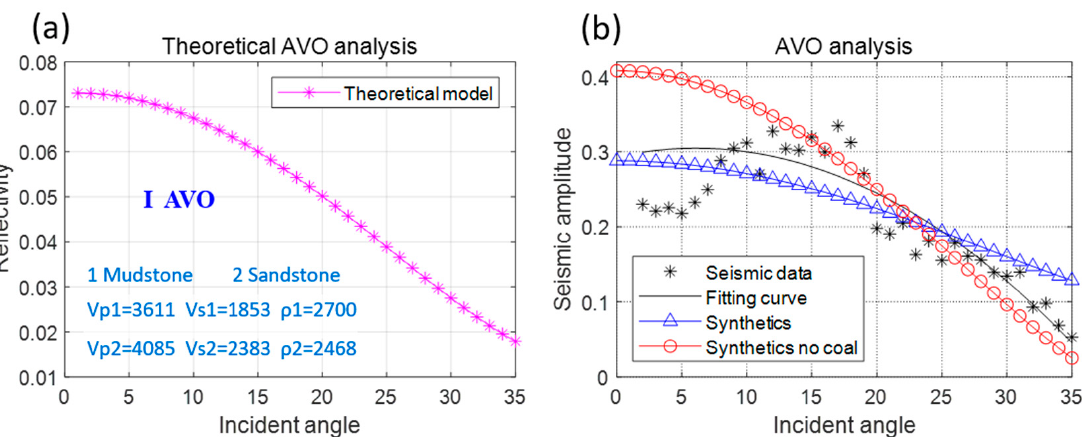
Figure 19. AVO response of the top interface of a water-bearing sandstone: ( a ) Theoretical analysis; ( b ) AVO analysis.